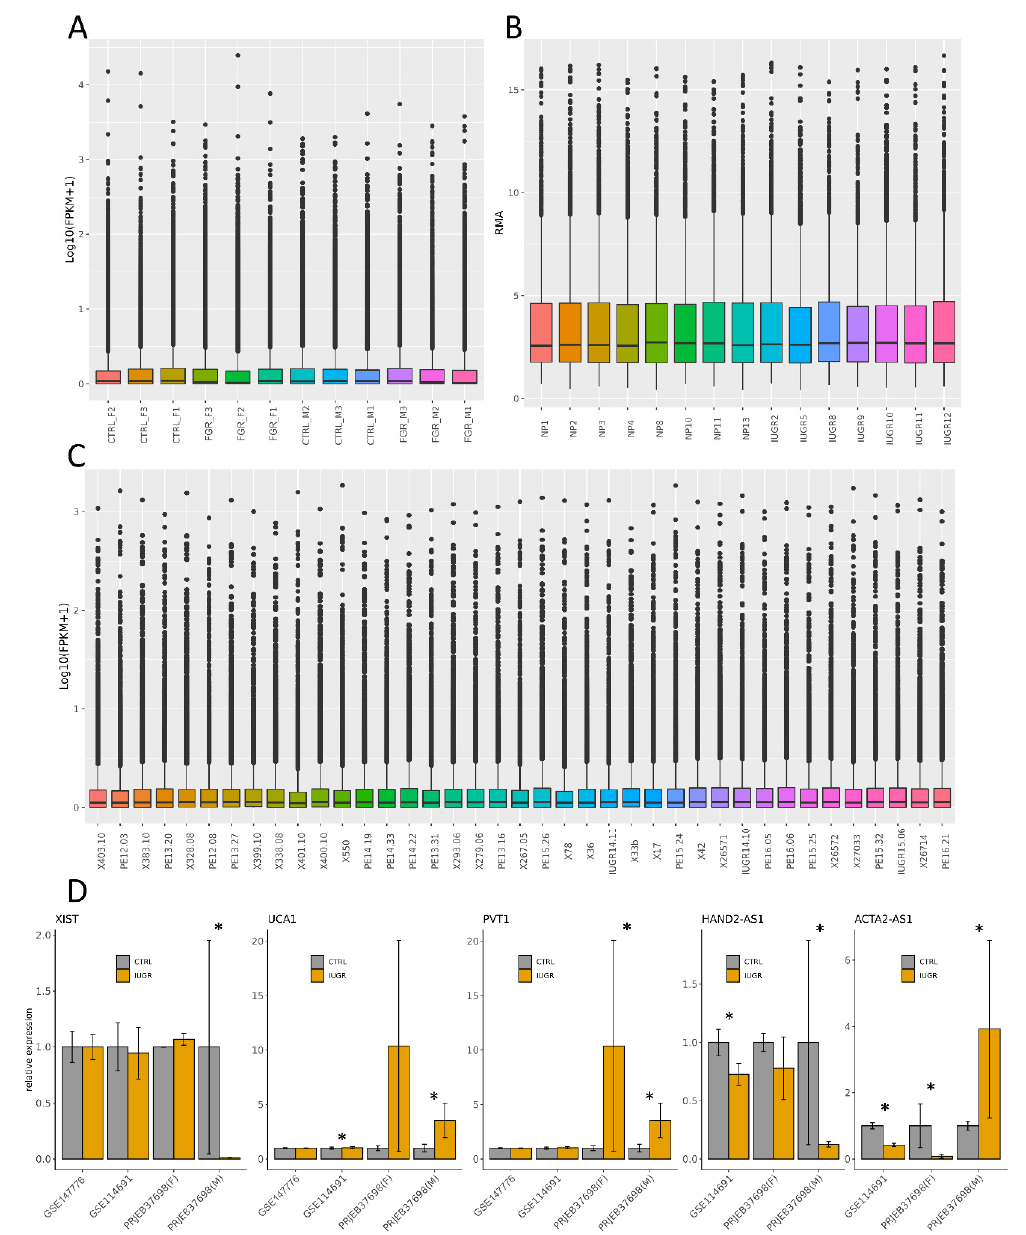
Figure 6. General expression profiles of samples from ( A ) the current study (PRJEB37698), ( B ) microarray (GSE14776) and ( C ) RNA-Seq (GSE114691) projects, and ( D ) relative expression profiles of the selected lncRNAs were computed based on the mean FPKM values (GSE114691 and PRJEB37698) and RMA (GSE14776). Error bars represent the SEM value. Stars (*) indicate confirmed statistically significant differentially expressed loci.